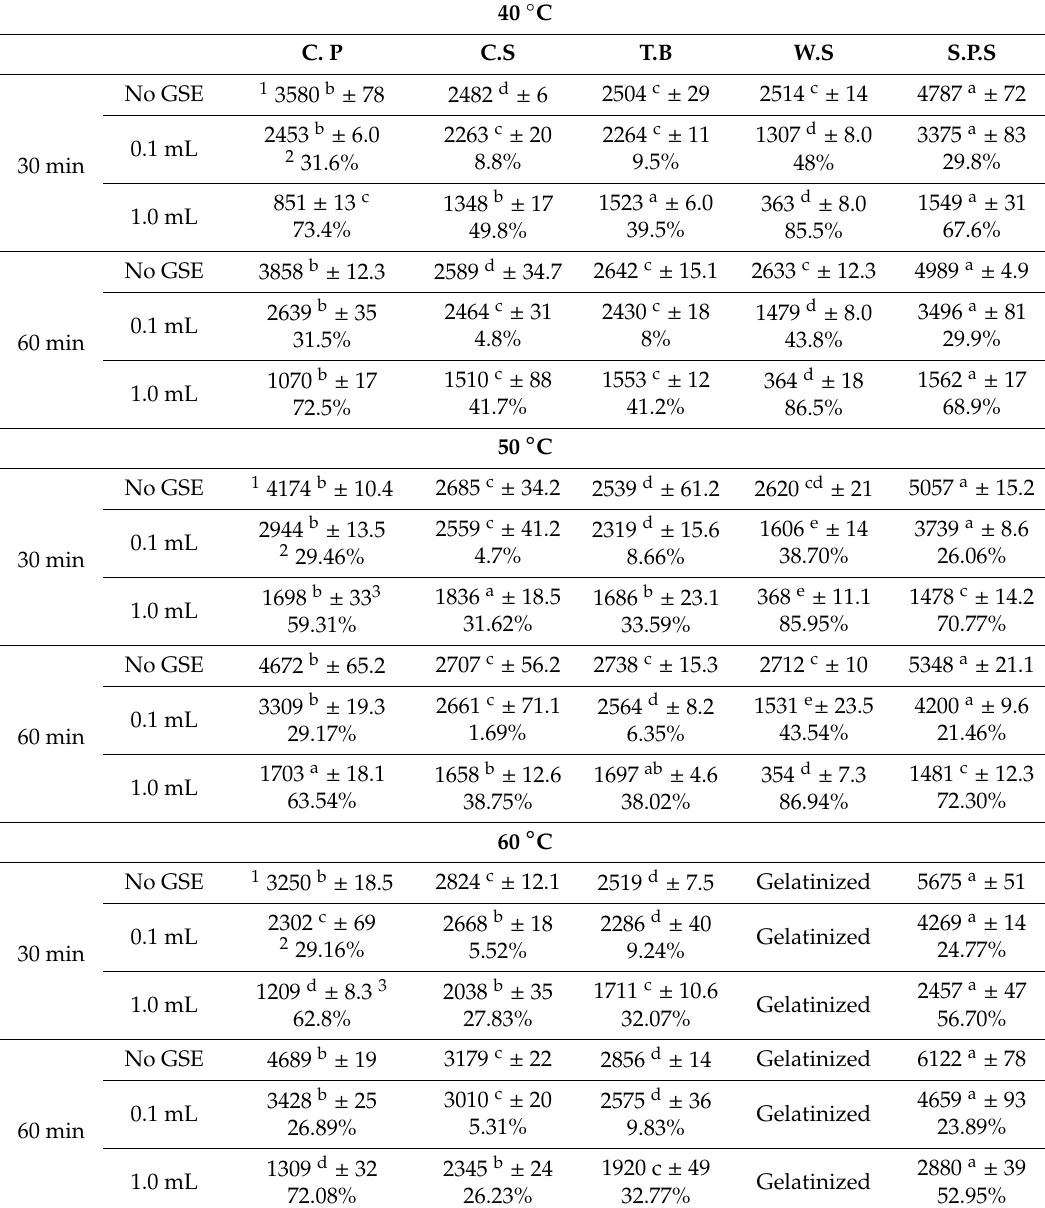
Table 1. The e ff ect of germinated sorghum extract (GSE) on the peak viscosity (cP) of starches annealed at 40, 50, and 60 ◦